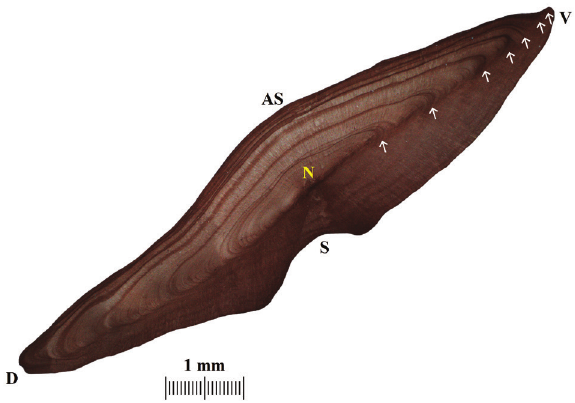
Figure 2. Transversal cuts of otolith sagitta of Pacific hake, Merluccius productus , in the Gulf of California. N = nucleus, D = dorsal, V = ventral, S = sulcus, AS =Antisulcus. Female of 68 cm